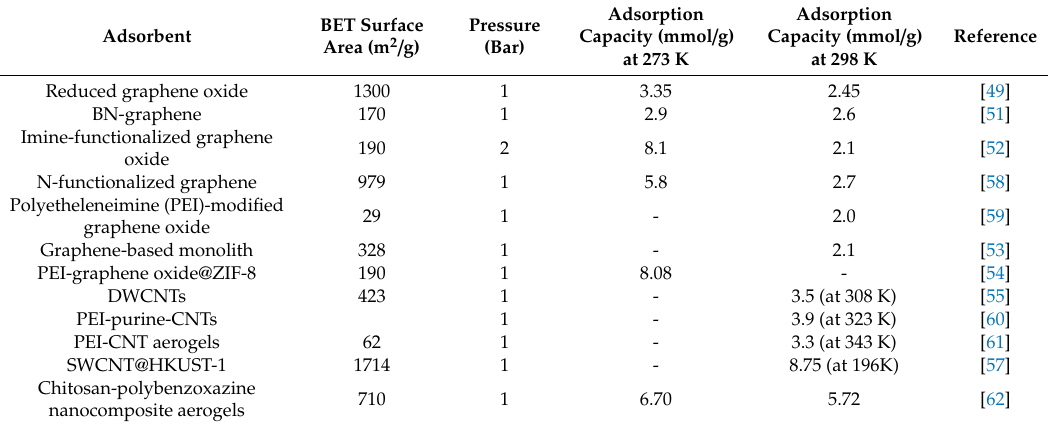
Table 2. CO 2 capture performances, recently reported by graphene, graphene oxide, carbon nanotubes (CNTs), and their